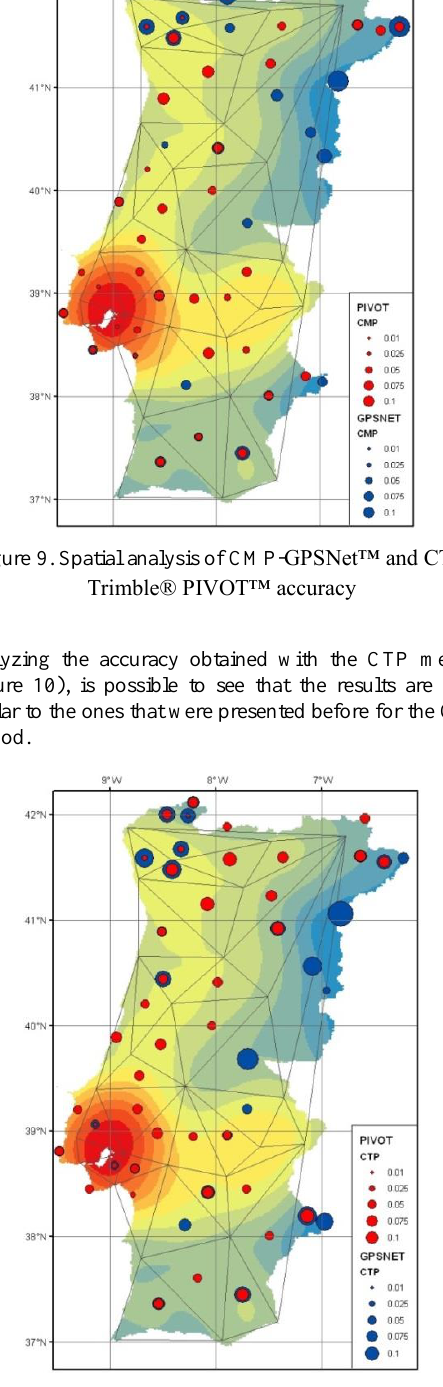
Figure 10. Spatial analysis of CMP-GPSNet™ and CTP- Trimble® PIVOT™